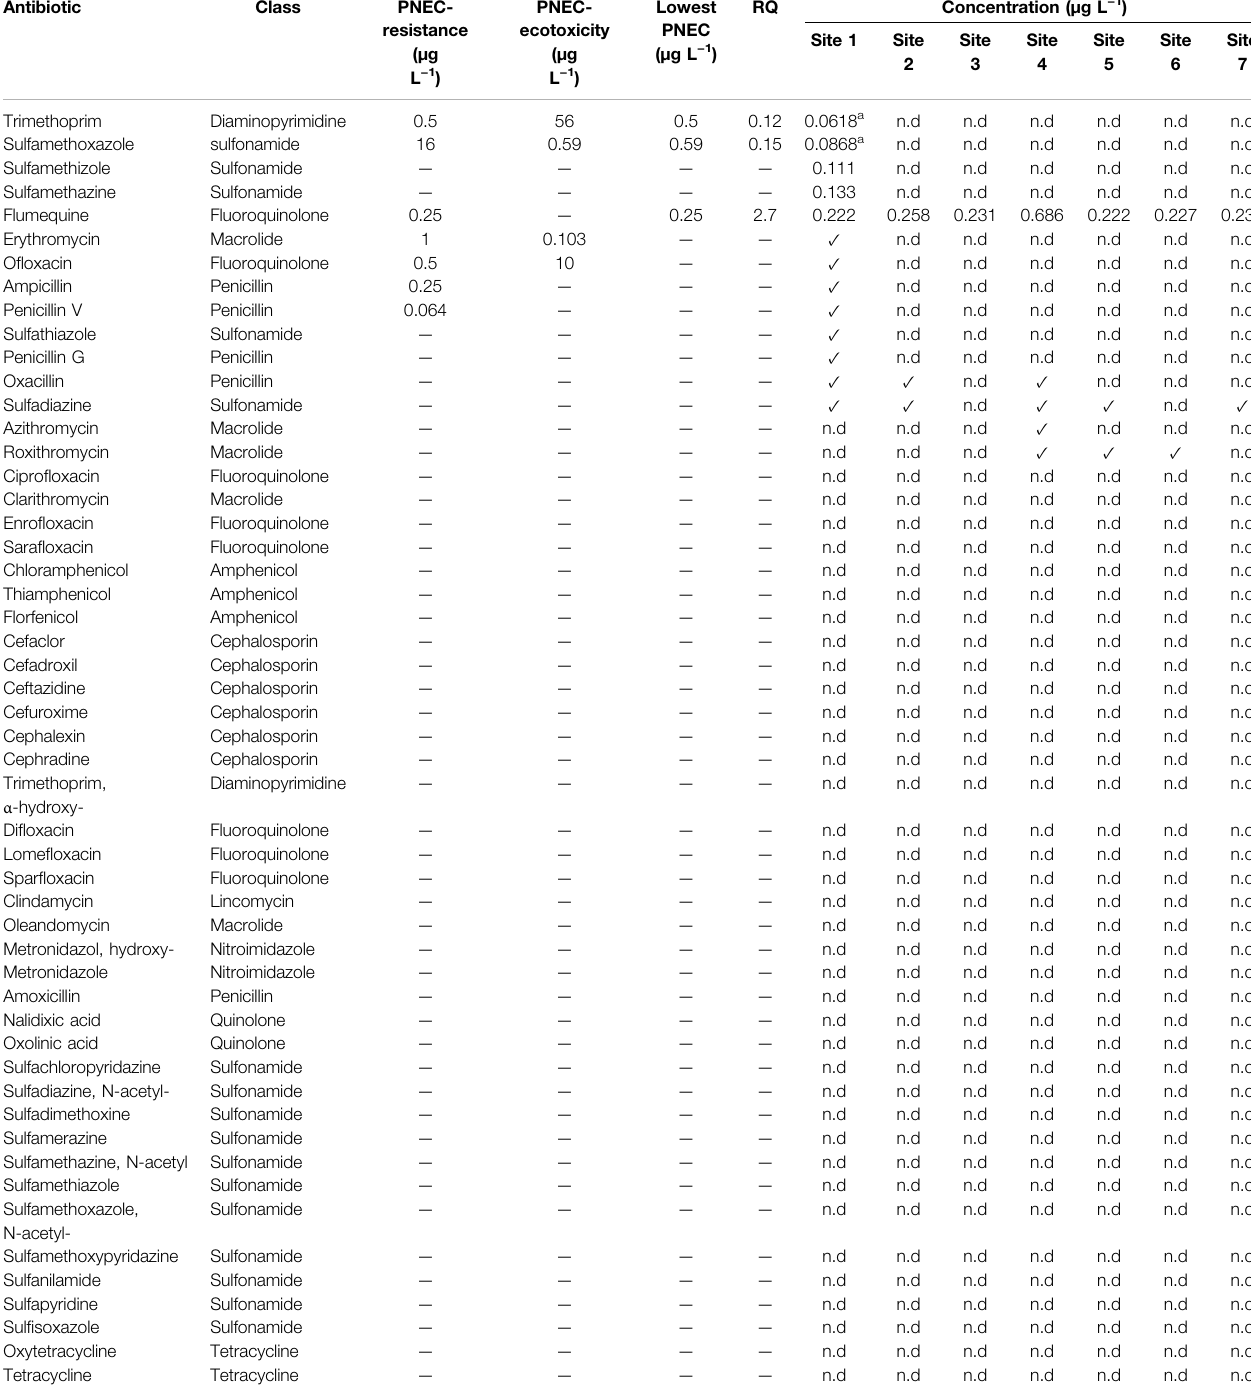
TABLE 2 | Detected antibiotics and health risk assessment.